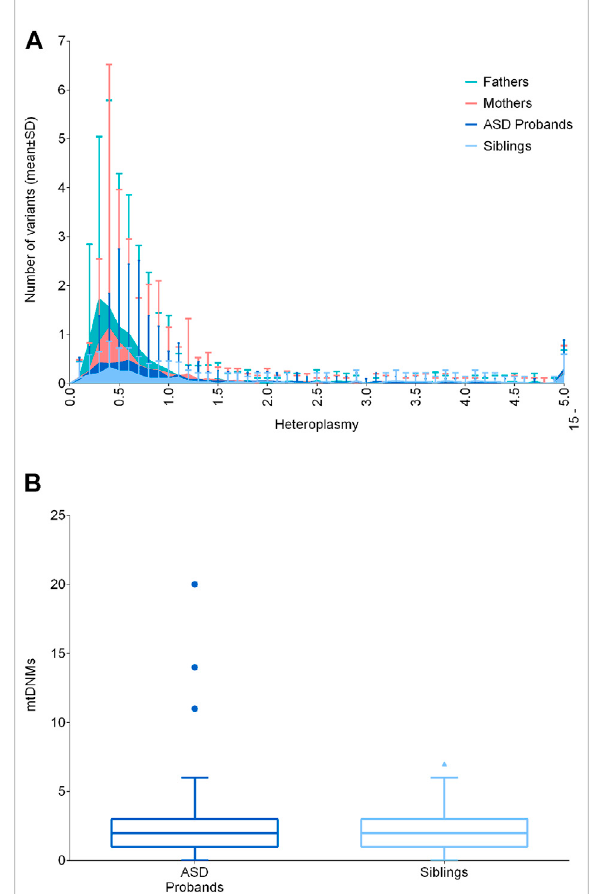
FIGURE 2 Distribution of low-level heteroplasmic and mtDNA de novo variants. (A) Frequency of low-level heteroplasmic variants below 15% of heteroplasmy in ASD probands, siblings, mothers and fathers. Heteroplasmy was distributed inclasses increasing of 0.1% until 4.9%, and a single class from 5% to 15%. Data are shown as mean ± standard deviation (SD) (B) De novo variants in ASD probands and siblings, comparing the variants between 0.2% and 15% of heteroplasmy not inherited from mothers. Data are shown as Tukey box and whiskers